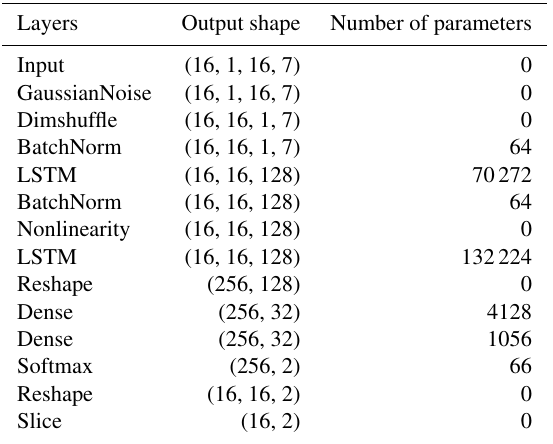
Table 7. Layers, output shapes, and number of parameters for the LSTM